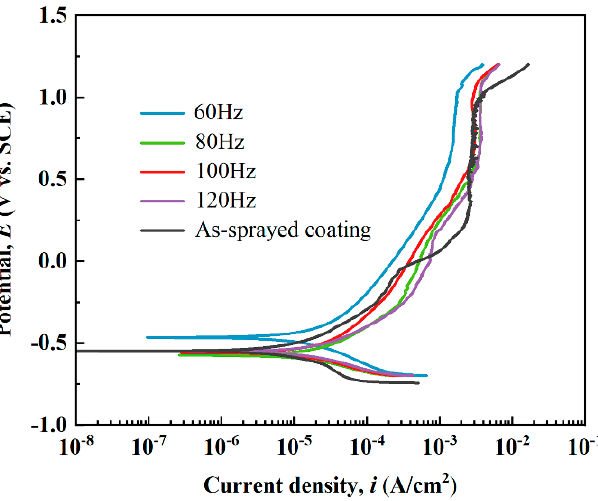
Figure 8. Potentiodynamic polarization curves of the as-sprayed and laser-remelted metallic glass coatings. Table 3. Electrochemical measurement parameters during polarization.